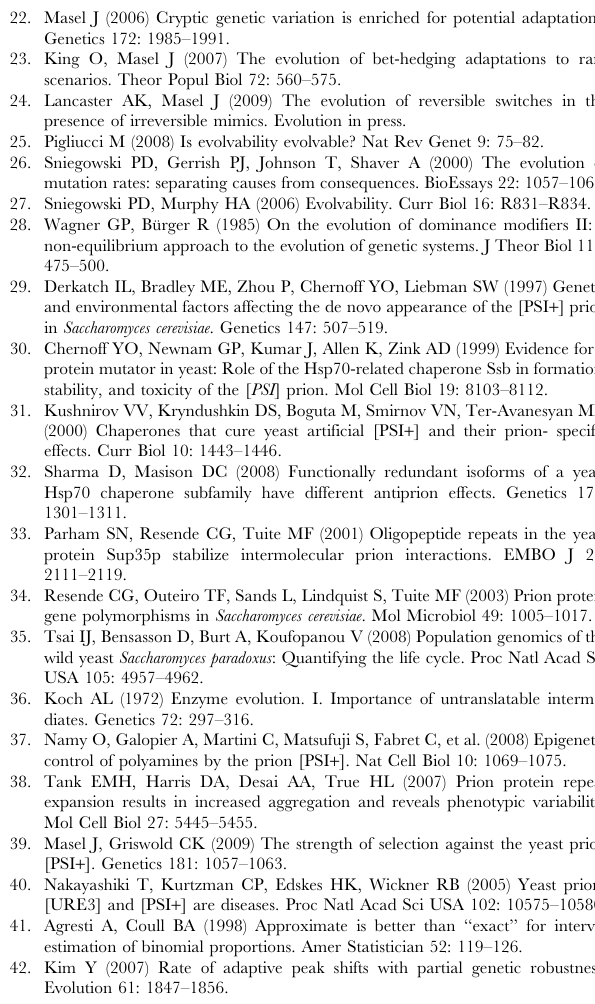
Figure S1 Fitness contours in environment two as a function of E b and E b . The approximation E i & E b 1 2